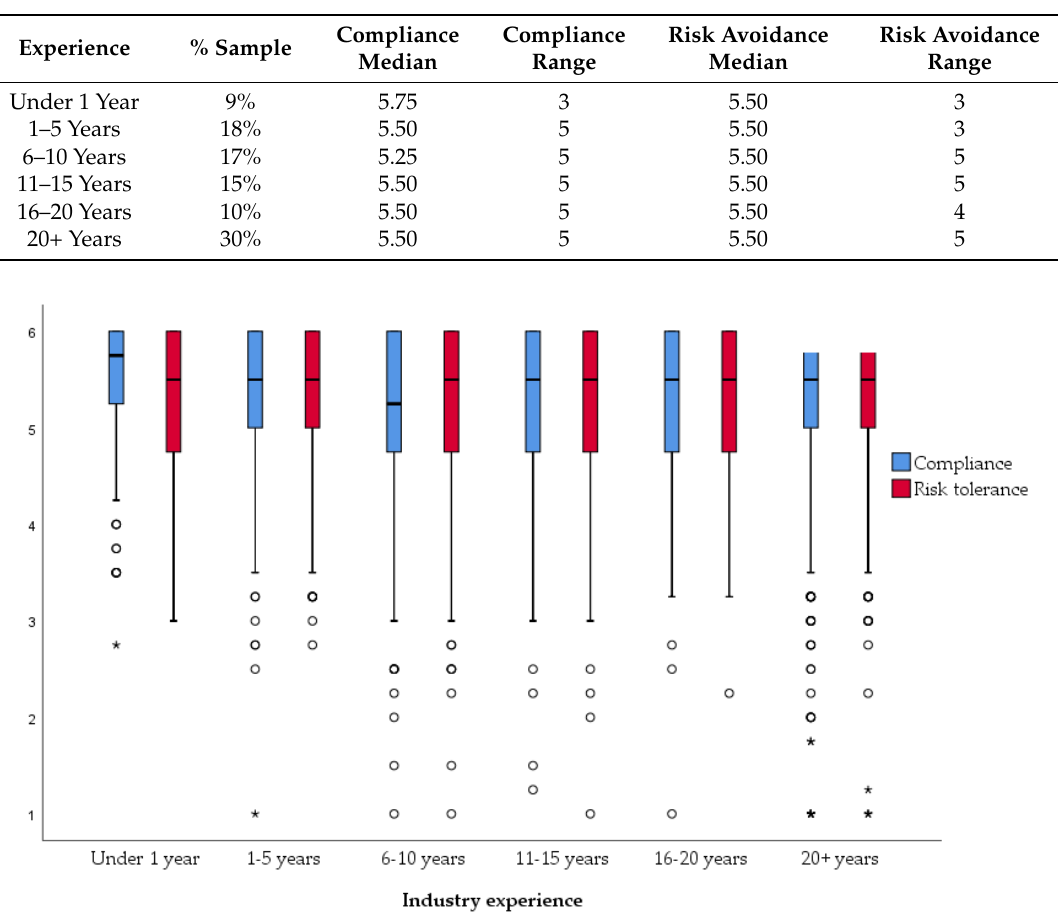
Figure 2. A box plot depicting the distribution of average compliance and risk avoidance among workers based on mining experience. The circles are outliers and the asterisks are extreme outliers. About 95% of the data falls between the inner fences (i.e., the t-bars that extend from the boxes).